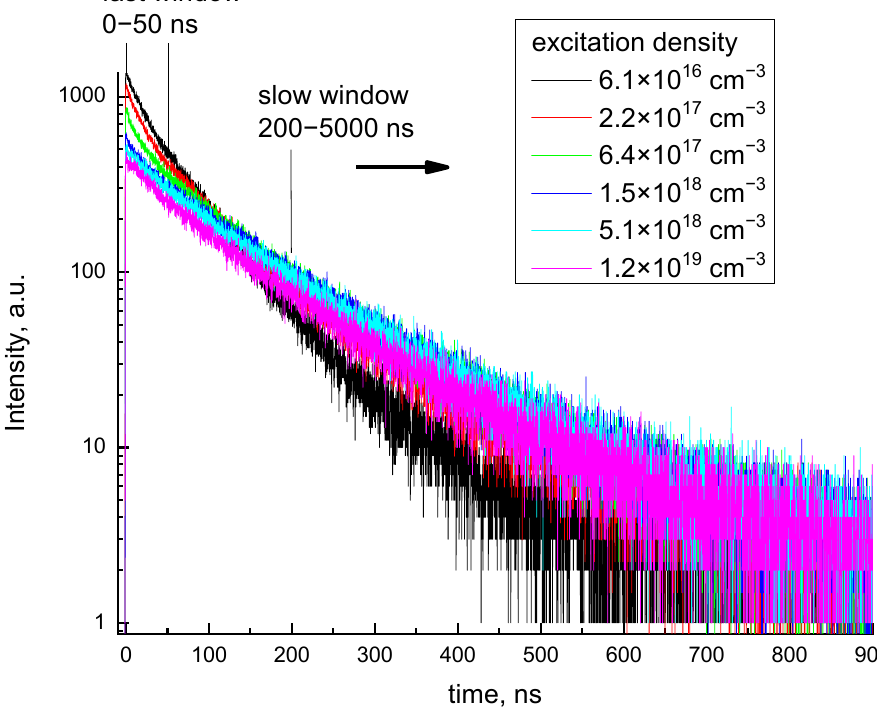
Figure 4. Decay curves of GAGG:Ce measured at the excitation density in the range from N 0 max = 3.6 × 10 16 cm − 3 to 7 × 10 18 cm − 3 , E ex = 6.2 eV.